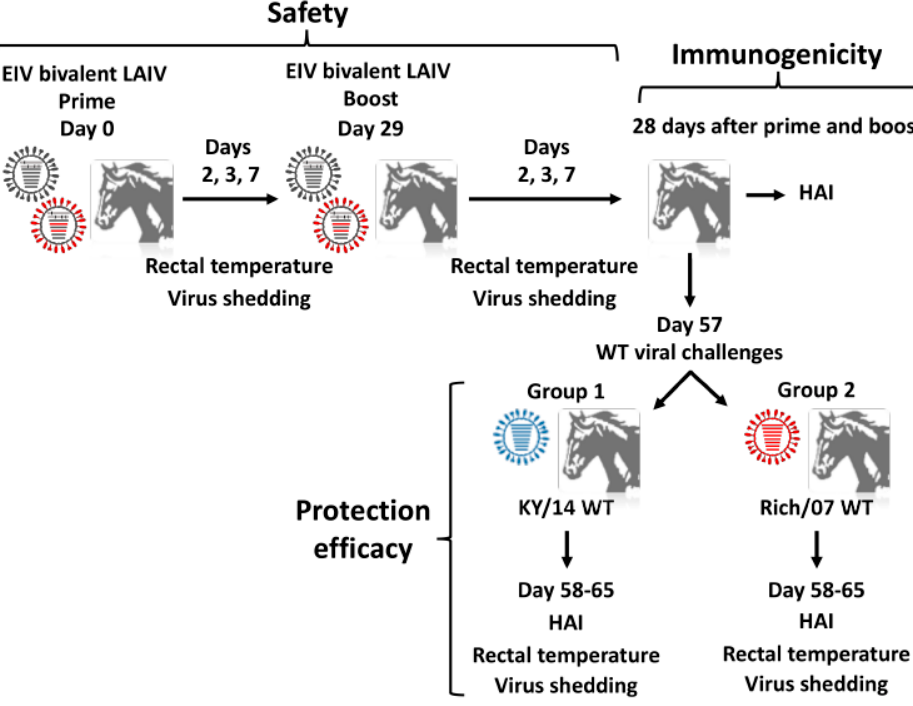
Figure 5. Schematic representation of the vaccination and challenge protocol: One-to-two year-old horses of both sexes ( n = 12) were randomly separated into group 1 ( n = 6) and group 2 ( n = 6) and inoculated by aerosol inhalation with a virus preparation containing 3 × 10 8 FFU of clade 1 Ohio/03 LAIV and 3 × 10 8 FFU of clade 2 Rich/07 LAIV using a prime-boost regimen. Individual rectal temperature and viral shedding were measured in each horse before and at days 2, 3, and 7 after each dose (safety). Twenty-eight days after the boost, samples were collected and presence of serum antibodies was assessed by HAI (immunogenicity). Fifty-seven days after prime, vaccinated ( n = 12) and mock-vaccinated ( n = 6) horses were randomly separated into group 1 and group 2 and challenged by aerosol inhalation with 5 × 10 7 EID 50 of A/equine/Kentucky/2014 WT (KY/14 WT; n = 6 vaccinated group 1 and n = 3 mock-vaccinated) or 5 × 10 7 EID 50 of Rich/07 WT ( n = 6 vaccinated group 2 and n = 3 mock-vaccinated) to assess protection against clade 1 and 2 EIVs, respectively. Rectal temperatures and virus shedding were evaluated (protection efficacy) for eight days after challenge.